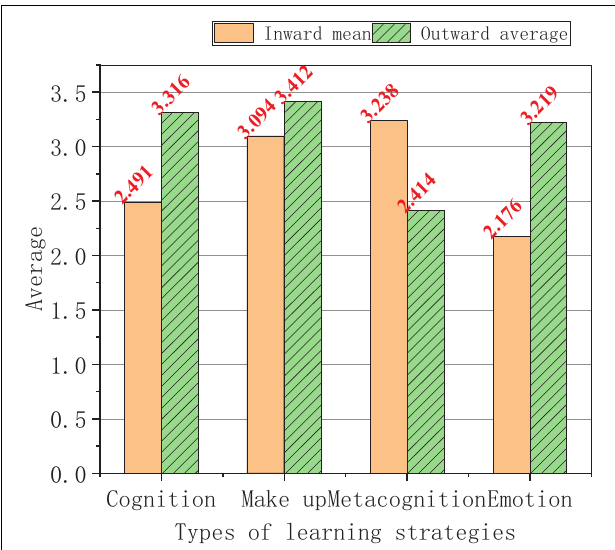
FIGURE 12 | Relation between the students’ personalities and their use frequency of learning